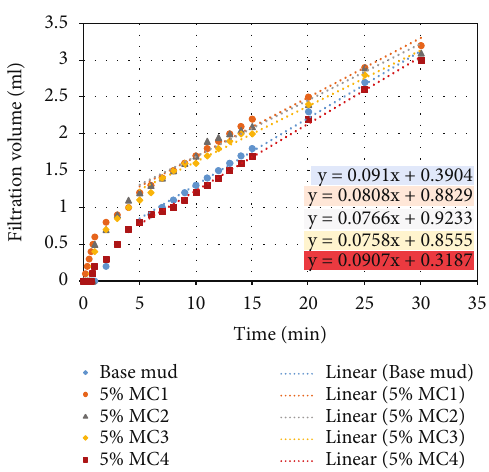
Figure 12: Filtrate volume vs. time for the base mud and as function adding di ff erent cuttings in 5% concentration.